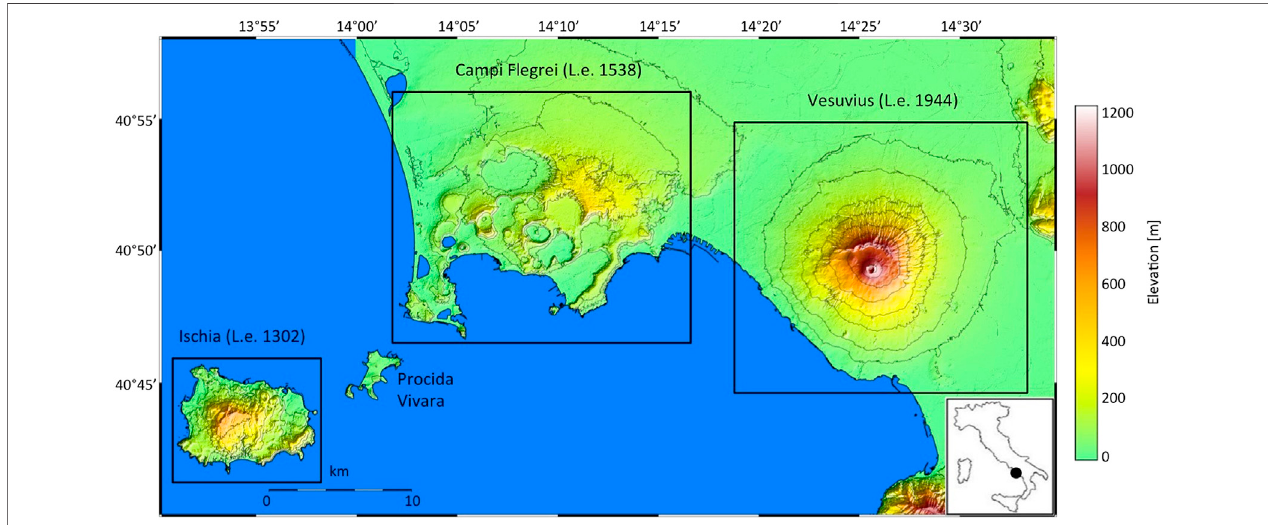
FIGURE1| MapoftheNeapolitanvolcanoes(Vesuvius,CampiFlegreiandIschia).The fi gureshowstheyearoflasteruption(L.e.)ofthethreevolcanoes.Thecolor scale represents elevation. The difference in height between the level lines is 150 m. SeeAcocella and Funiciello (2006) for structural details and Passaro et al. (2016) for